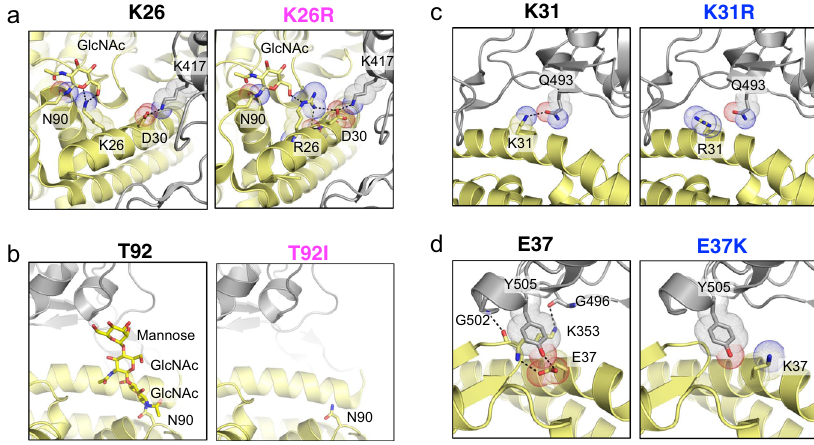
Fig. 3 Structural basis of interaction between human ACE2 polymorphic variants and SARS-CoV-2 S-protein. a K26R, b T92I, c K31R and d E37K. Interaction mapping done using PDB